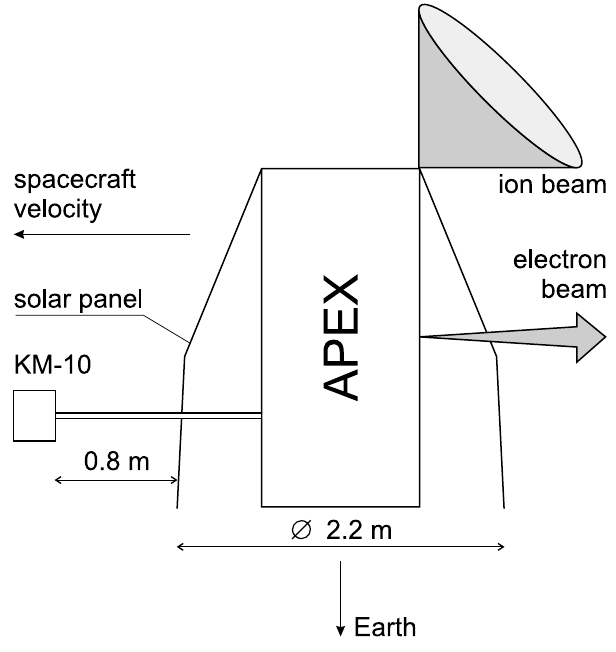
Fig. 1. Schematic drawing of the APEX payload configuration (with locations of the electron gun, plasma generator, solar panels, and